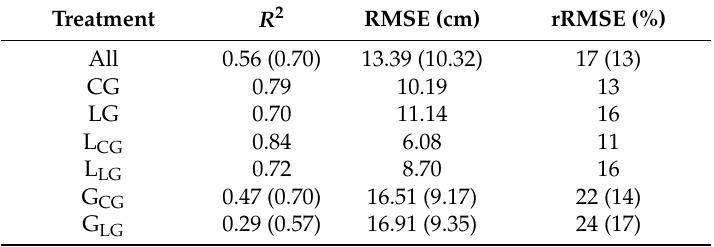
Table 2. Coefficients of determination ( R 2 ), root mean square errors (RMSE) and relative RMSE (rRMSE) of linear regression analysis between manual height measurements (CH R ) and UAV-based RGB imaging (CH D ) for the whole dataset (All) and the different treatments: clover-grass (CG), lucerne-grass (LG) as well as the pure stands of legumes (L CG , L LG ) and grass (G CG , G LG ) of the mixtures, respectively. Values in brackets represent results for the dataset without pure grass swards of the second cut.